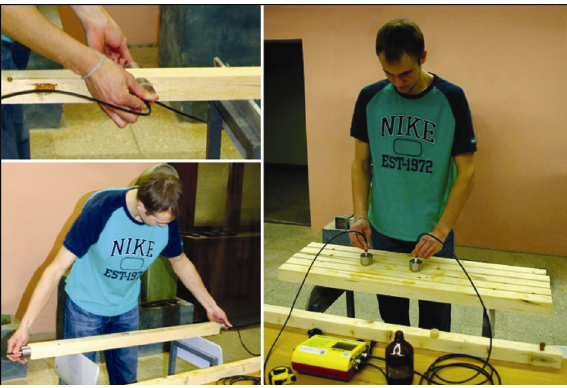
Fig. 2. Conducting tests with a TICO Ultrasound Instrument device and 54 kHz transducers